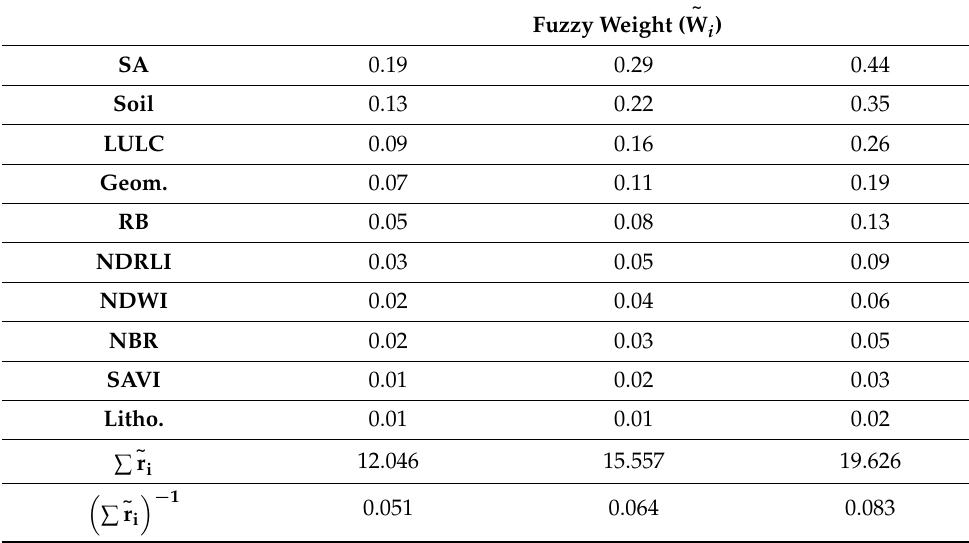
Table 6. Relative fuzzy weights of each factor.